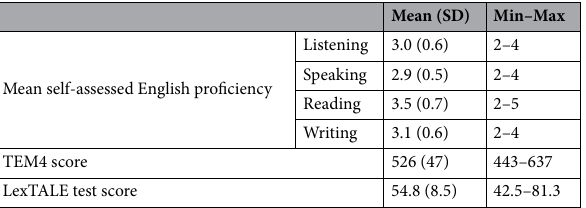
Table 1. Summary of the participants’ mean self-assessed English proficiency, CET 4 score, and LexTALE test score (M ± SD and